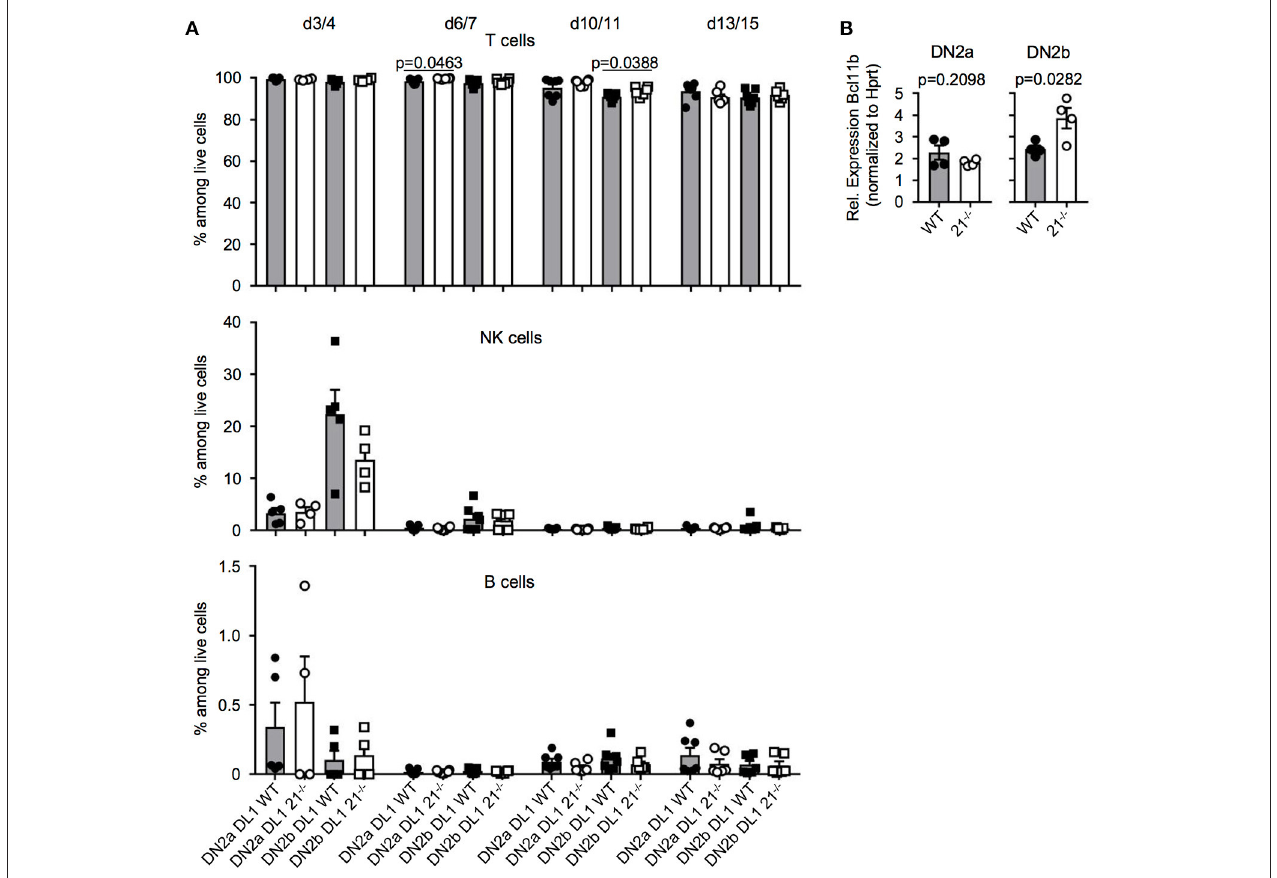
FIGURE 6 | T-lineage and alternative lineage fate decisions are mostly unaltered in the absence of miR-21. (A) Sorted DN2a and DN2b cells were cultured on OP9-DL1 cells for up to 15 days. Generation of T, NK, and B cells was assessed by flow cytometry at indicated periods of time. Pooled data of two independent experiment. Each dot represents one mouse, n = 4-7 per group. (B) Analysis of expression of Bcl11b in sorted DN2a and b thymocytes of WT or miR-21 − / − mice by quantitative RT-PCR. Expression levels were normalized to Hprt . Each dot represents one mouse, n =